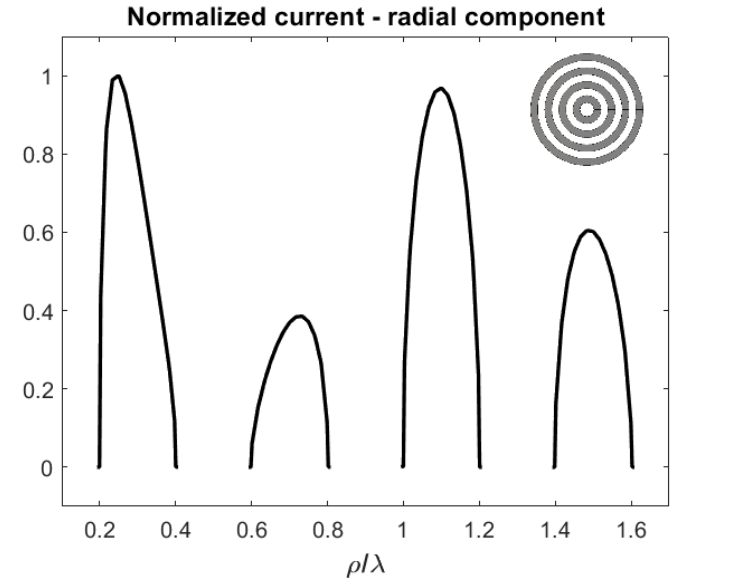
Figure 5. Behavior of the radial component of the current density for the geometry #2 of Table 1 (sketched in the inset) for an incidence angle θ inc = 0 ◦